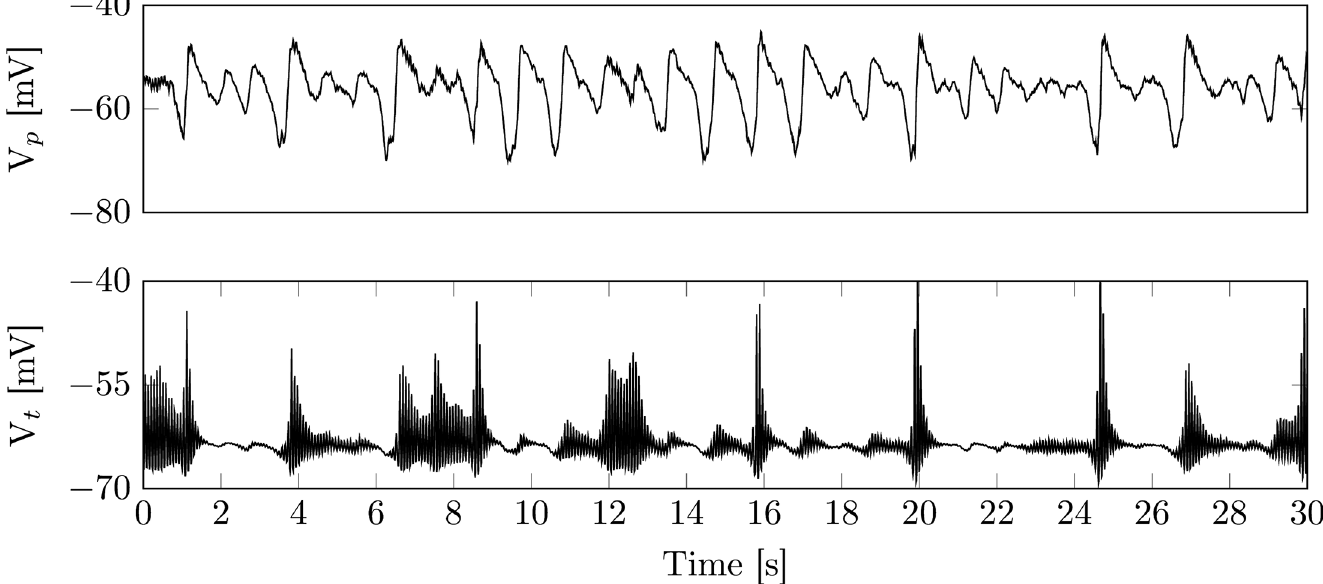
Fig 5. Example time series of sleep stage N3. Shown are membrane voltages of the cortical pyramidal (top) and the thalamic relay population (bottom). During N3 the model shows ongoing slow oscillatory activity. In contrast to sleep stage N2, SOs cannot be identified as isolated events. Furthermore, there are no isolated spindle oscillations and spindle activity is time-locked to SOs. Parameters are given in Table 2.